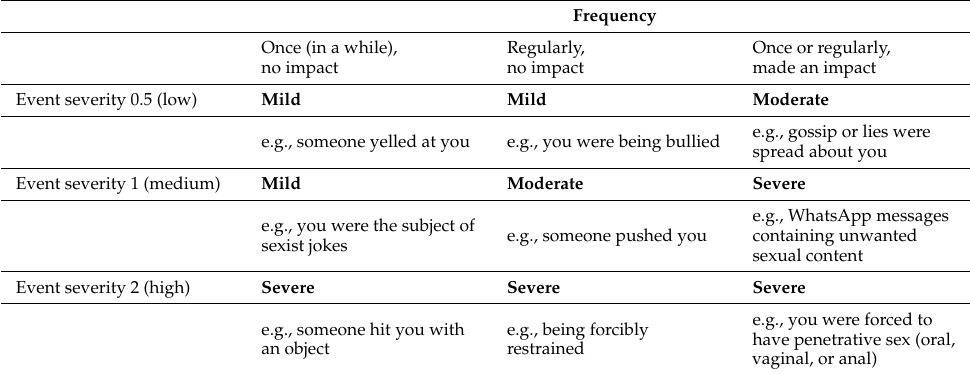
Table 1. Response classification based on expert-rated event severity, and respondent-rated event frequency and